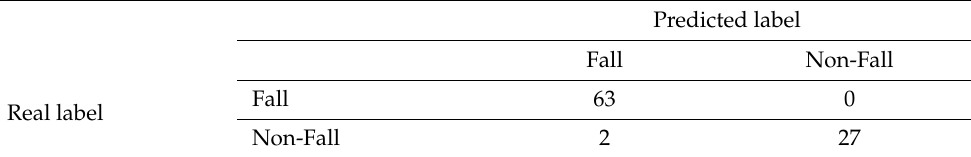
Figure 6. URFD dataset: example frames. Table 3. URFD dataset: The confusion matrix obtained by applying our